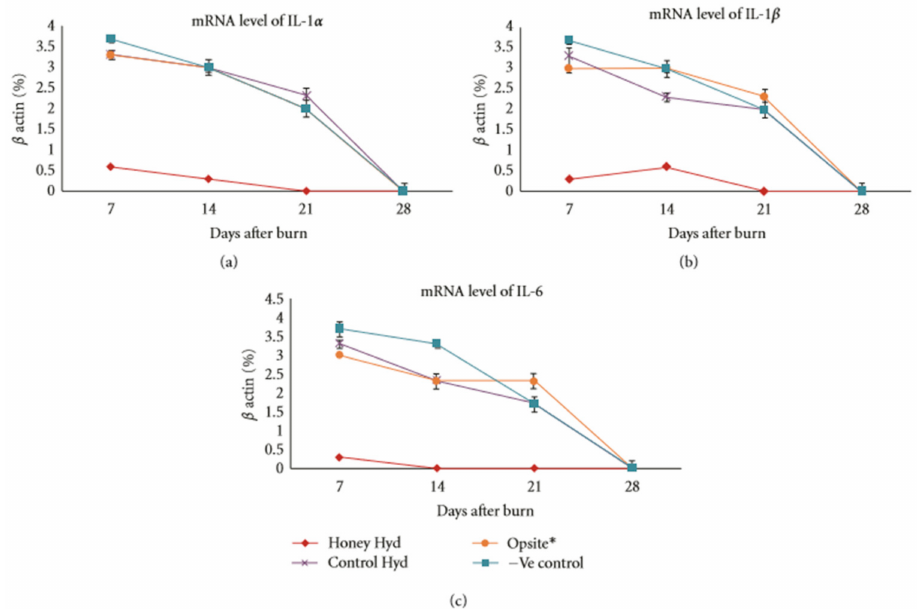
Figure 6. Honey reduces inflammatory cytokine expression. mRNA expression of ( a ) IL-1 α , ( b ) IL-1 β , and ( c ) IL-6 in a rat burn wound model treated with a control hydrogel, a commercial Opsite film dressing, the honey hydrogel, or non-treated (-Ve) control, normalized to β -actin. Reproduced with permission from Zohdi et al., Evidence-based Complementary and Alternative Medicine ; published by Hindawi,